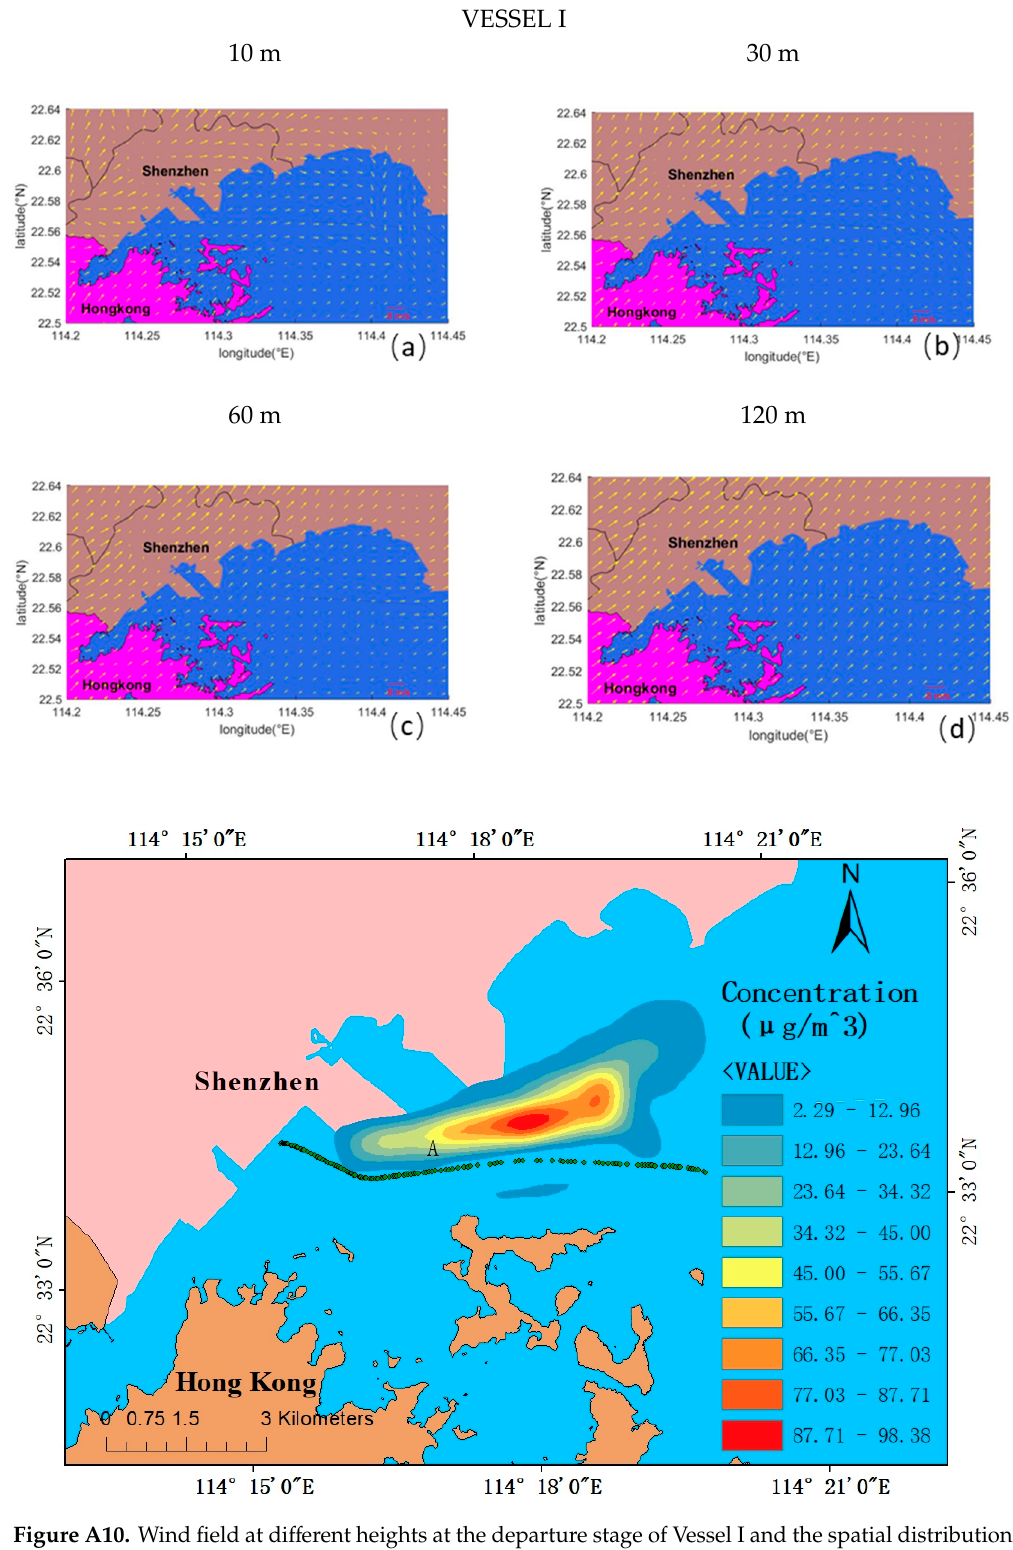
Figure A10. Wind field at different heights at the departure stage of Vessel I and the spatial distribution of the maximum concentration of each simulation grid during the simulation period. ( a ) 10m, ( b ) 30m, ( c ) 60m and ( d ) 120m.